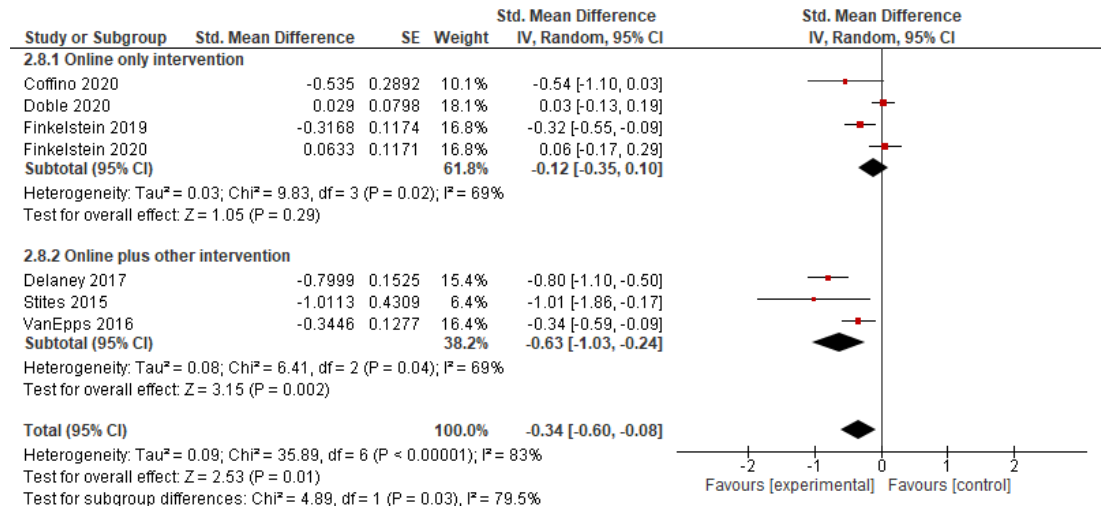
Figure A1. Energy: Sub-group analysis (online exclusive intervention vs. other).